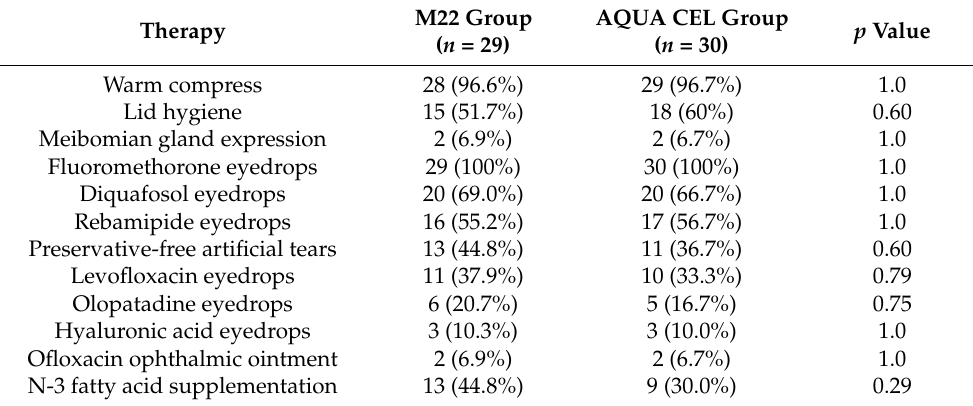
Table 3. Previous therapies for the study patients in M22 and AQUA CEL